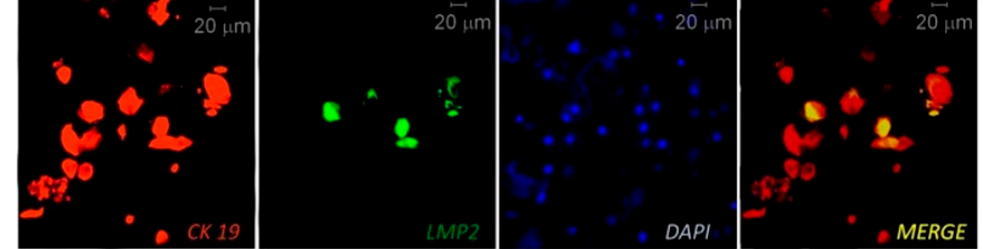
Figure 2. Immunofluorescent (IF) costaining of CK19 (junctional epithelial cell marker cytokeratin 19) and LMP2 (EBV latent membrane protein 2) to detect EBV-infected epithelial cells in samples taken from a periodontitis patient. The cell nuclei are counterstained with DAPI. Reprinted from [27].